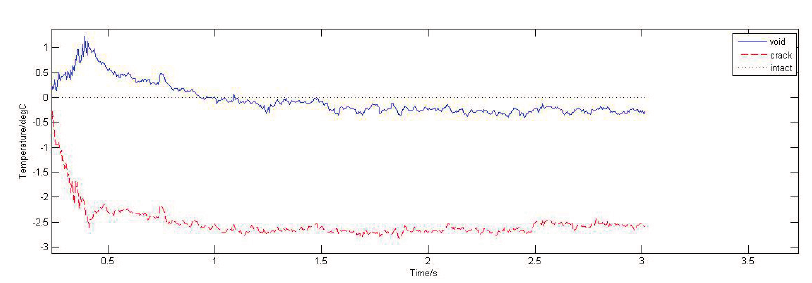
Figure 13. Average temperature curves.